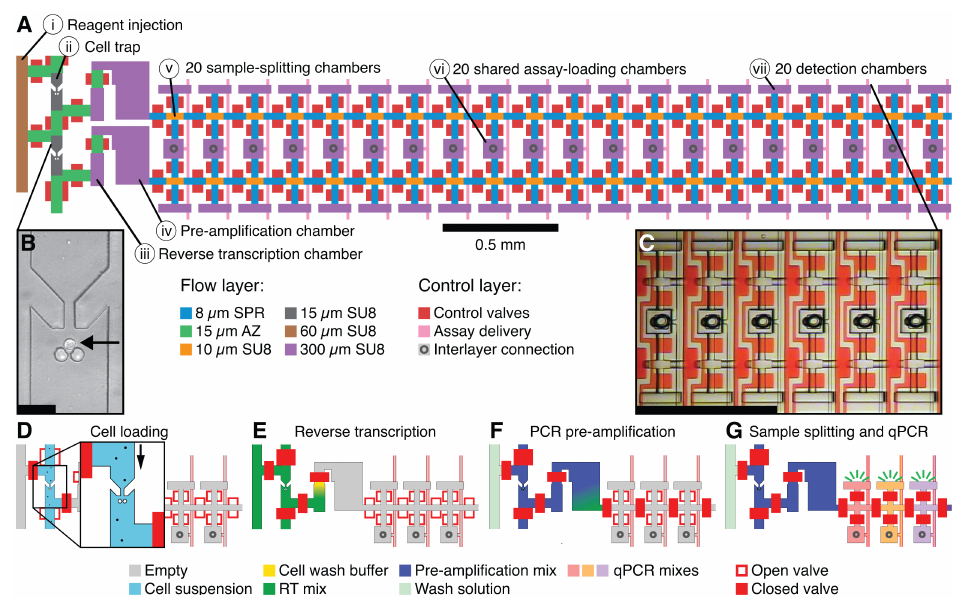
Fig 1. Multiplex RT-qPCR device schematic and operation. (A) Two cell-processing units. Components include (i) a reagent injection bus, (ii) a 0.3-nL cell capture chamber, (iii) a 10-nL reverse transcription (RT) chamber, (iv) a 50-nL pre-amplification chamber, (v) twenty 0.15-nL sample-splitting chambers, (vi) twenty shared assay-delivery chambers, and (vii) twenty 6.4-nL detection chambers. The “flow” layer is made up of features of six different heights. Control valves and assay-delivery channels are on the same 25 μ m high SU8 “control” layer. Assay delivery from the control layer to the flow layer occurs through laser-ablated interlayer connections. Scale bar 0.5 mm. (B) Optical micrograph of a single K562 cell (indicated by a black arrow) caught in a cell trap. Scale bar 50 μ m. (C) Optical micrograph of a subsection of the detection array. Control valves are coloured red. Scale bar 0.5 mm. (D-G) Schematic illustration of device operation. (D) Single cells are first loaded into the device, then washed, isolated, and lysed in situ . (E) Reverse transcription brew is then injected into the RT chamber, mixed with the lysate, and then the device is thermocycled. (F) Similarly, multiplexed pre-amplification mix is injected into the device, mixed with cDNA, and then the device is again thermocycled. (G) Finally, the pre-amplification product is split between detection chambers for qPCR.